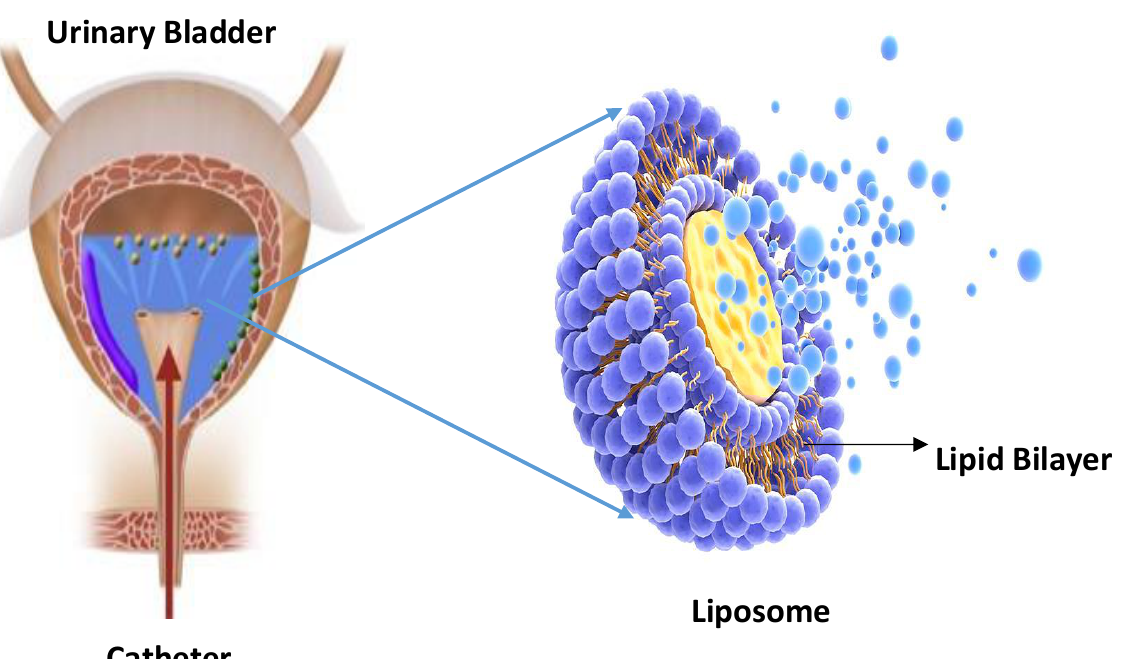
Figure 4. Typical liposome used in IDD, representing the structure of the lipid bilayer.